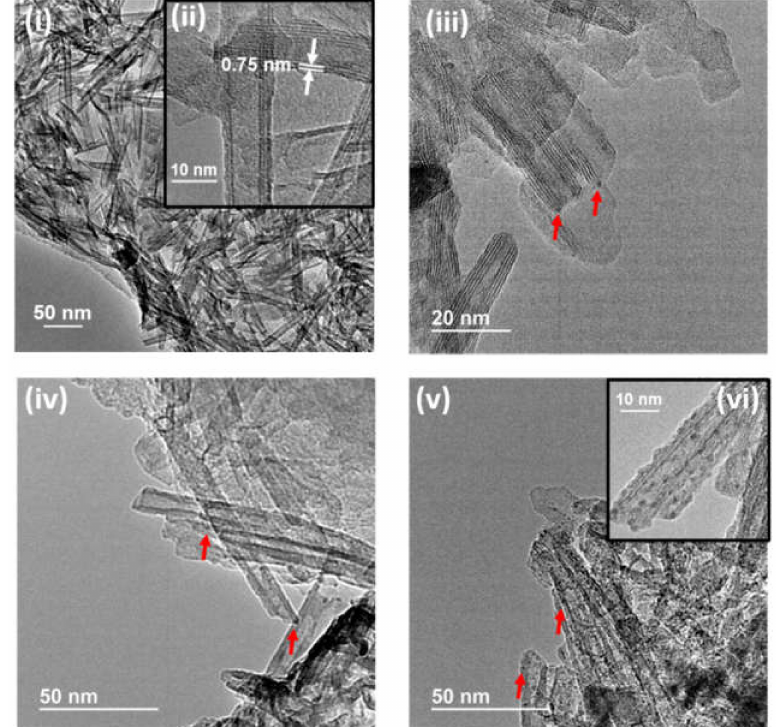
Figure 3. HR-TEM images of ( i ) the Na,H / TiNT; ( ii ) high-resolution image of the TiNT showing an interplanar distance of 0.75 nm; ( iii ) Ru / TiNT-0.5; ( iv ) Ru / TiNT-3.5; ( v ) Ru / TiNT-11, that comes with a high-resolution frame of a nanotube loaded with small nanoparticles ( vi ). Red arrows in the figures point to some small Ru NPs for frames ( iii – v